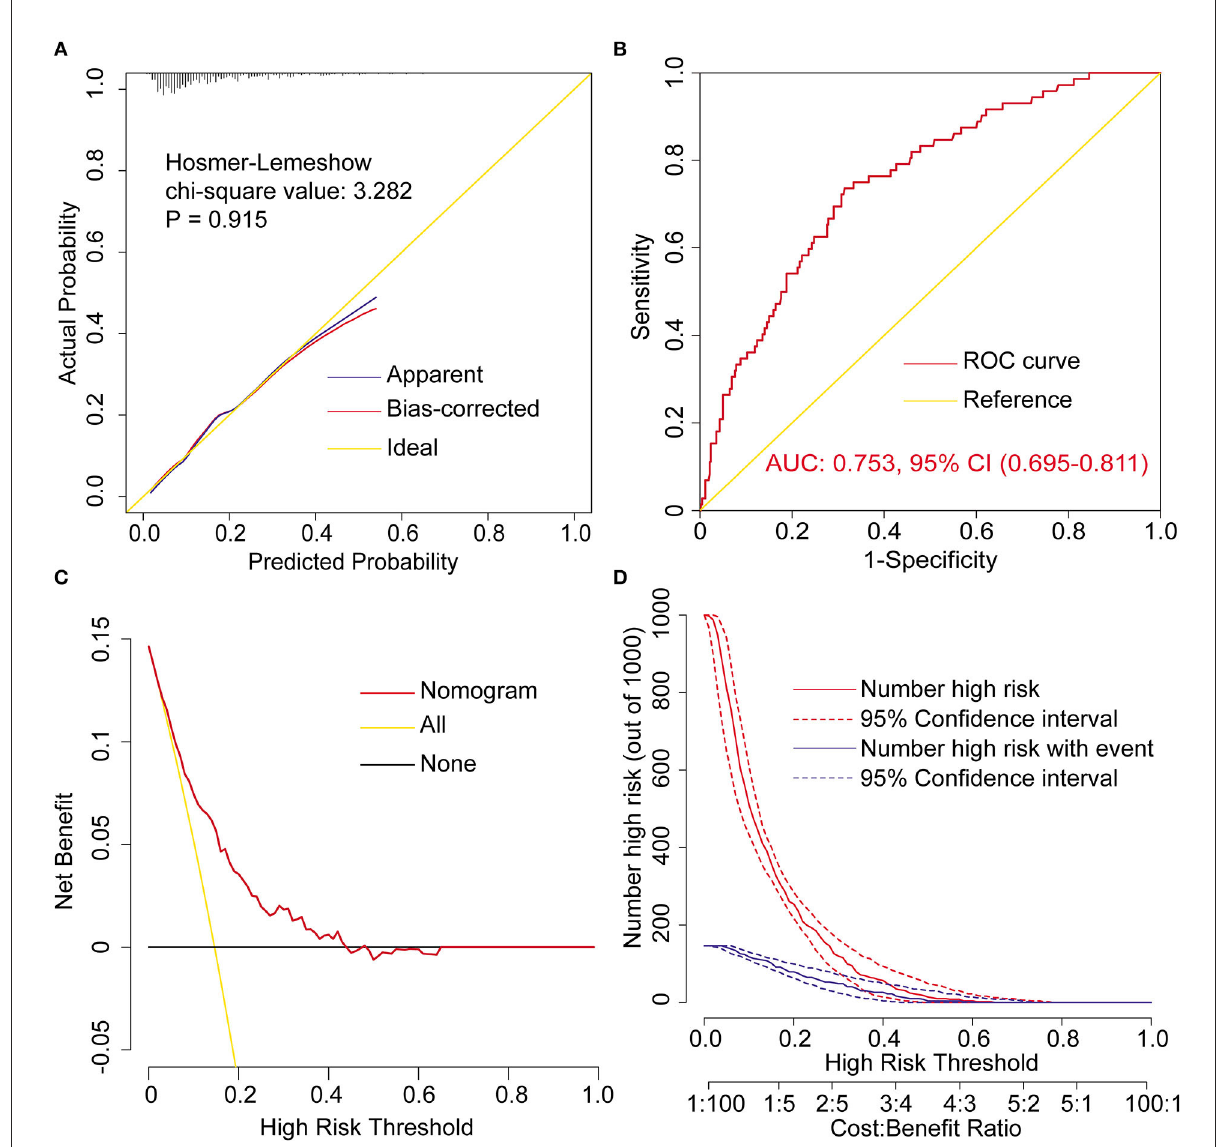
FIGURE2 Assessment of the prediction model for postoperative reintubation in patients undergoing AADS. (A) Calibration plot and the result of goodness-of -fit test, (B) ROC curves and corresponding AUC, (C) decision curves, and (D) clinical impact curves. AADS, Stanford type A acute aortic dissection surgery; AUC, area under the receiver operating characteristic curve; CI, confidence interval; ROC, receiver operating characteristic